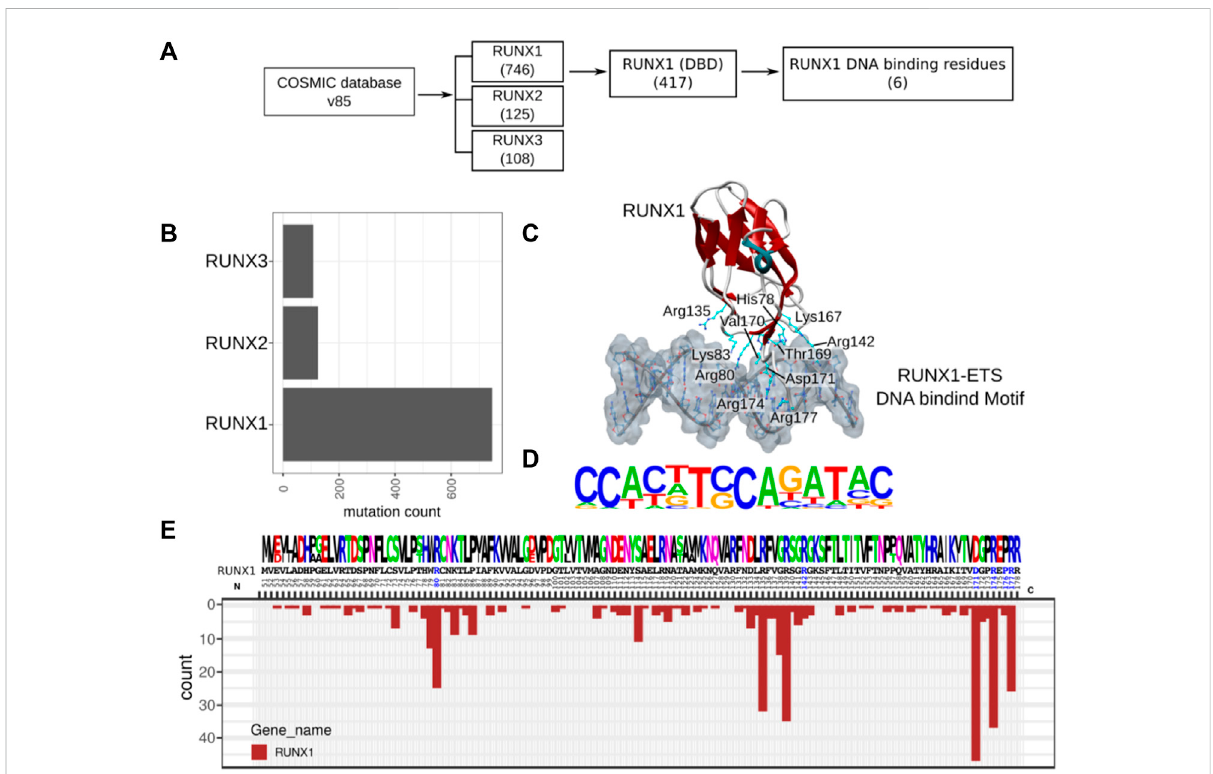
FIGURE 1 RUNX1 cancer-associated mutation and distribution within its DBD. (A) Flow chart for the selection of RUNX1 missense mutations from the COSMIC v85 database for our docking studies (B) Cancer-associated missense mutation across the RUNX family. RUNX1 contains approximately 746 missense mutations out of which 417 mutations reside within its DBD. The selection of candidate RUNX1 mutations for docking studies were donebasedonpotentialdirectDNAbindingeffectsandmutationalrecurrence.RUNX1hasthehighestnumberofmutationsincomparisonwith RUNX2 and RUNX3. (C) Structural cartoon for RUNX1-ETS complex on TCR enhancer (PDB ID: 3WU1) with highlighted DNA-bound six amino acids of RUNX1. (D) RUNX1-ETS DNA binding motif from published ChipSeq data (Accession: GSM1527839, GSE17954). (E) Conservation of amino acids across the paralogs of RUNX1 followed by distribution of mutations across the DNA binding